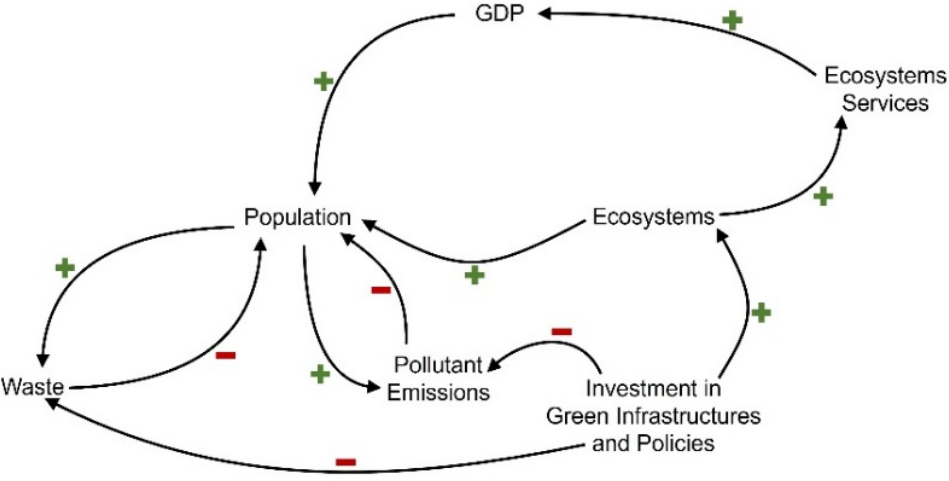
Figure 3. Casual loop diagram of the main model systems (own elaboration). Population System